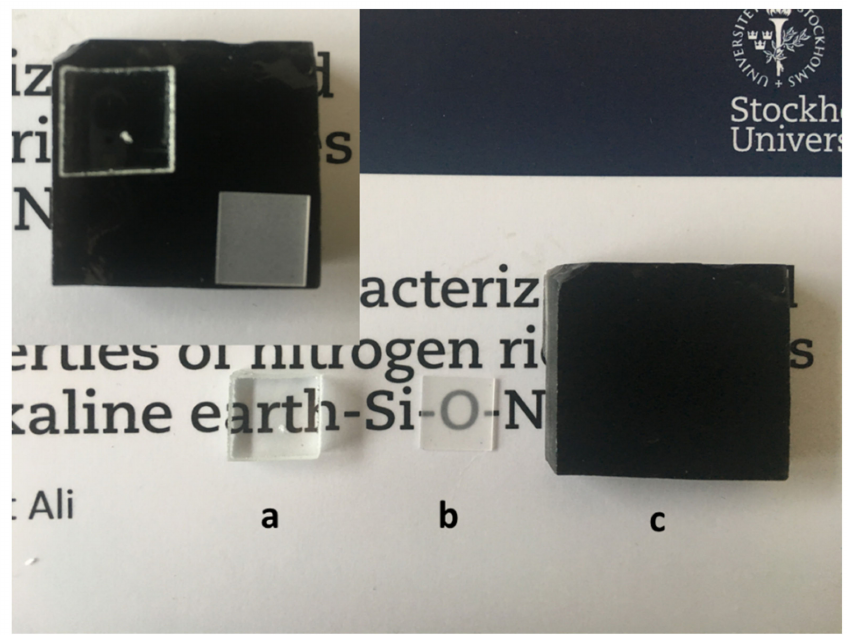
Figure 12. Photograph of the ( a ) coated float glass with La − Si − O − N thin films (the dot on the backside is a reference for not coated side), ( b ) sapphire substrate coated with La − Si − O − N thin film and ( c ) bulk oxynitride glass prepared by melt-quenching